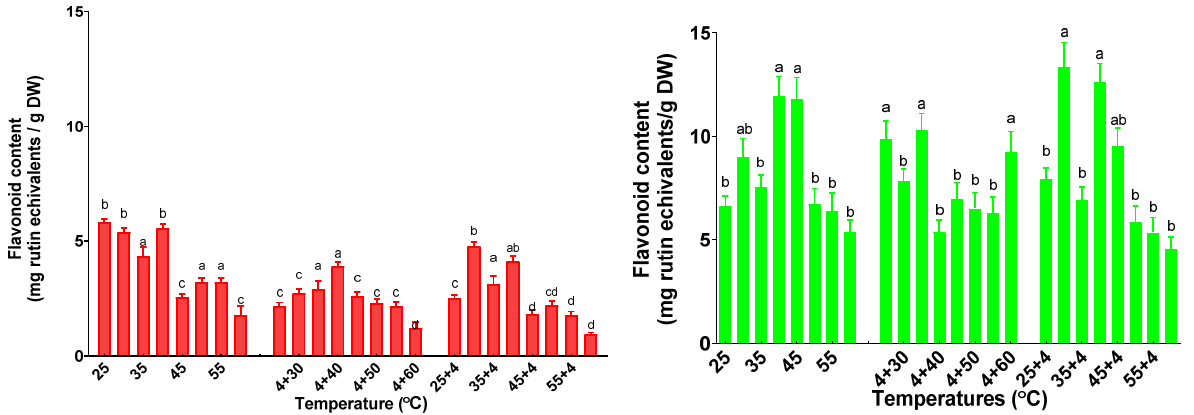
Figure 9. The flavonoid content of basil plants (red) and sage plants (green) plants subjected to different temperatures. Data sharing different letters are significantly different ( p < 0.05), while data sharing the same letters are not significantly different ( p > 0.05).